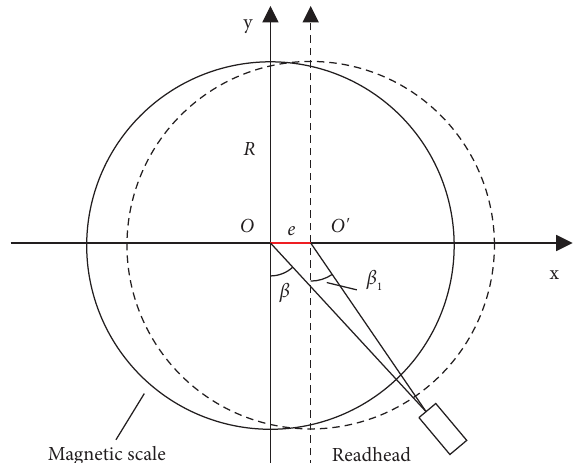
Figure 2: Te installation eccentricity error of the magnetic en- coder system.